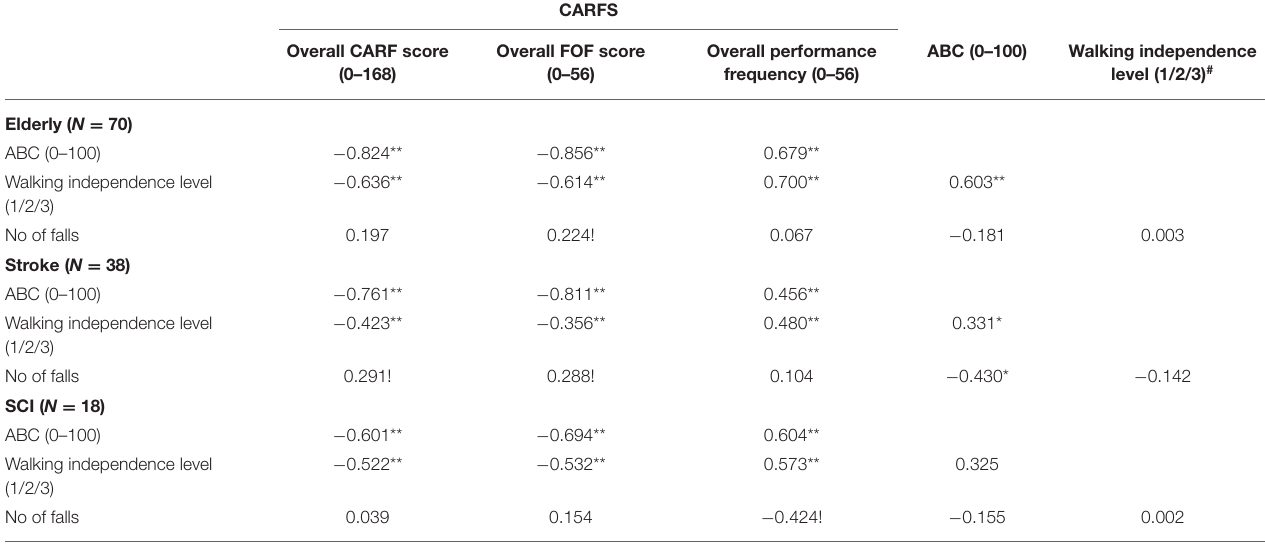
TABLE 4 | Convergent validity of the CARFS on relation with other fall risk